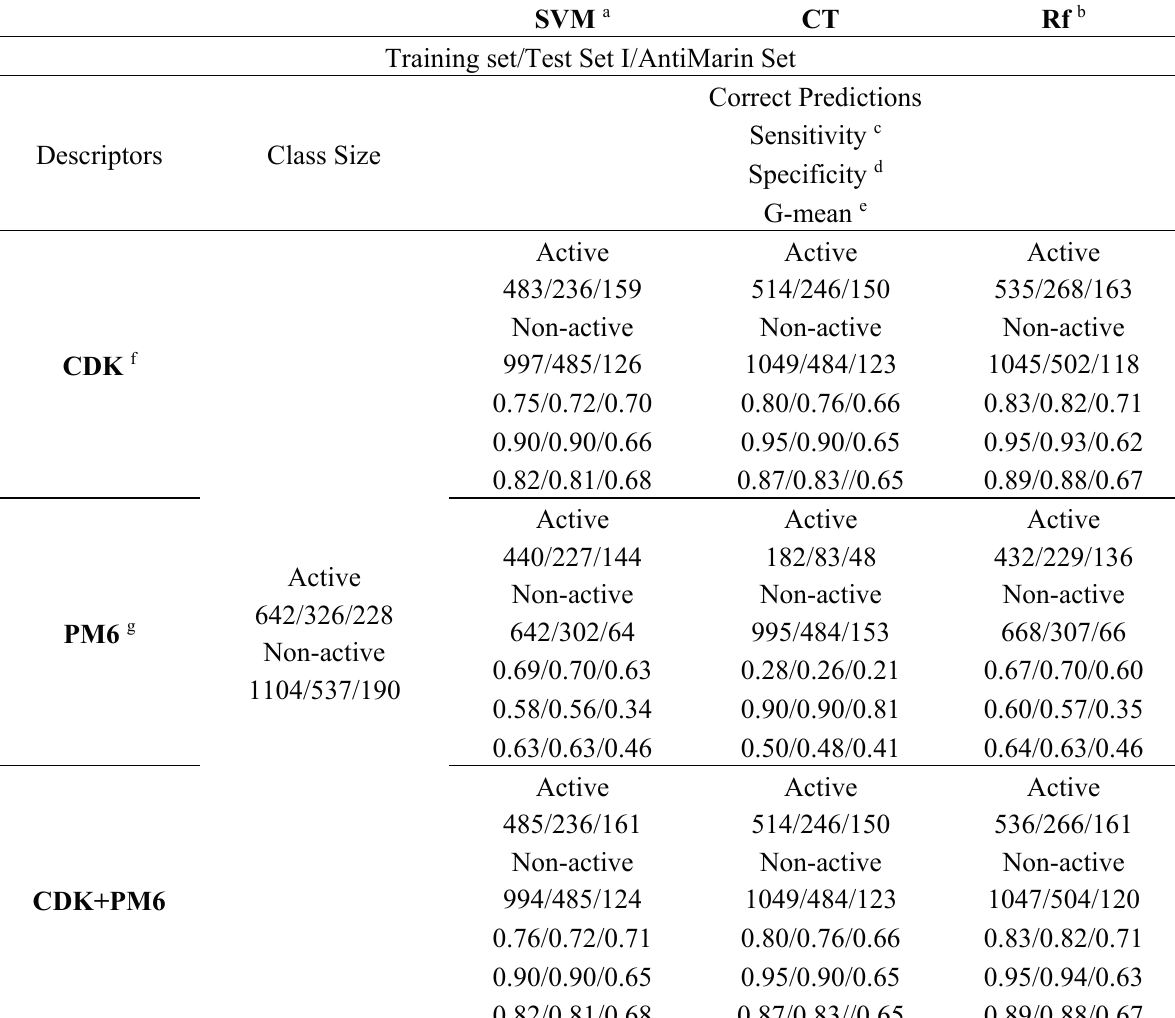
Table 3. Comparison of different ML techniques and descriptors for building antibiotic activity classification